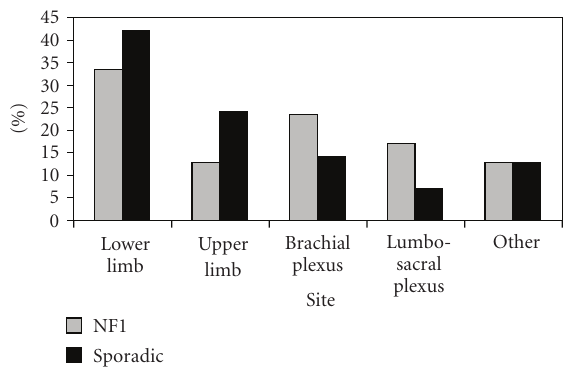
Figure 1: Tumour frequency by site.